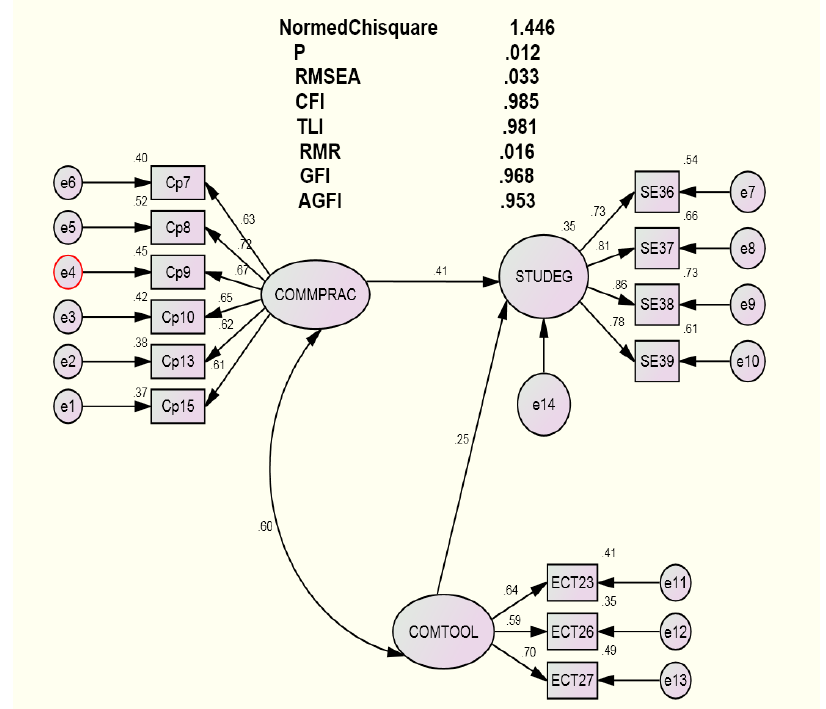
Figure 2 . Hypothesized Model. COMMPRAC = communication practices, COMTOOL = communication tools, STUDEG = student cognitive engagement.